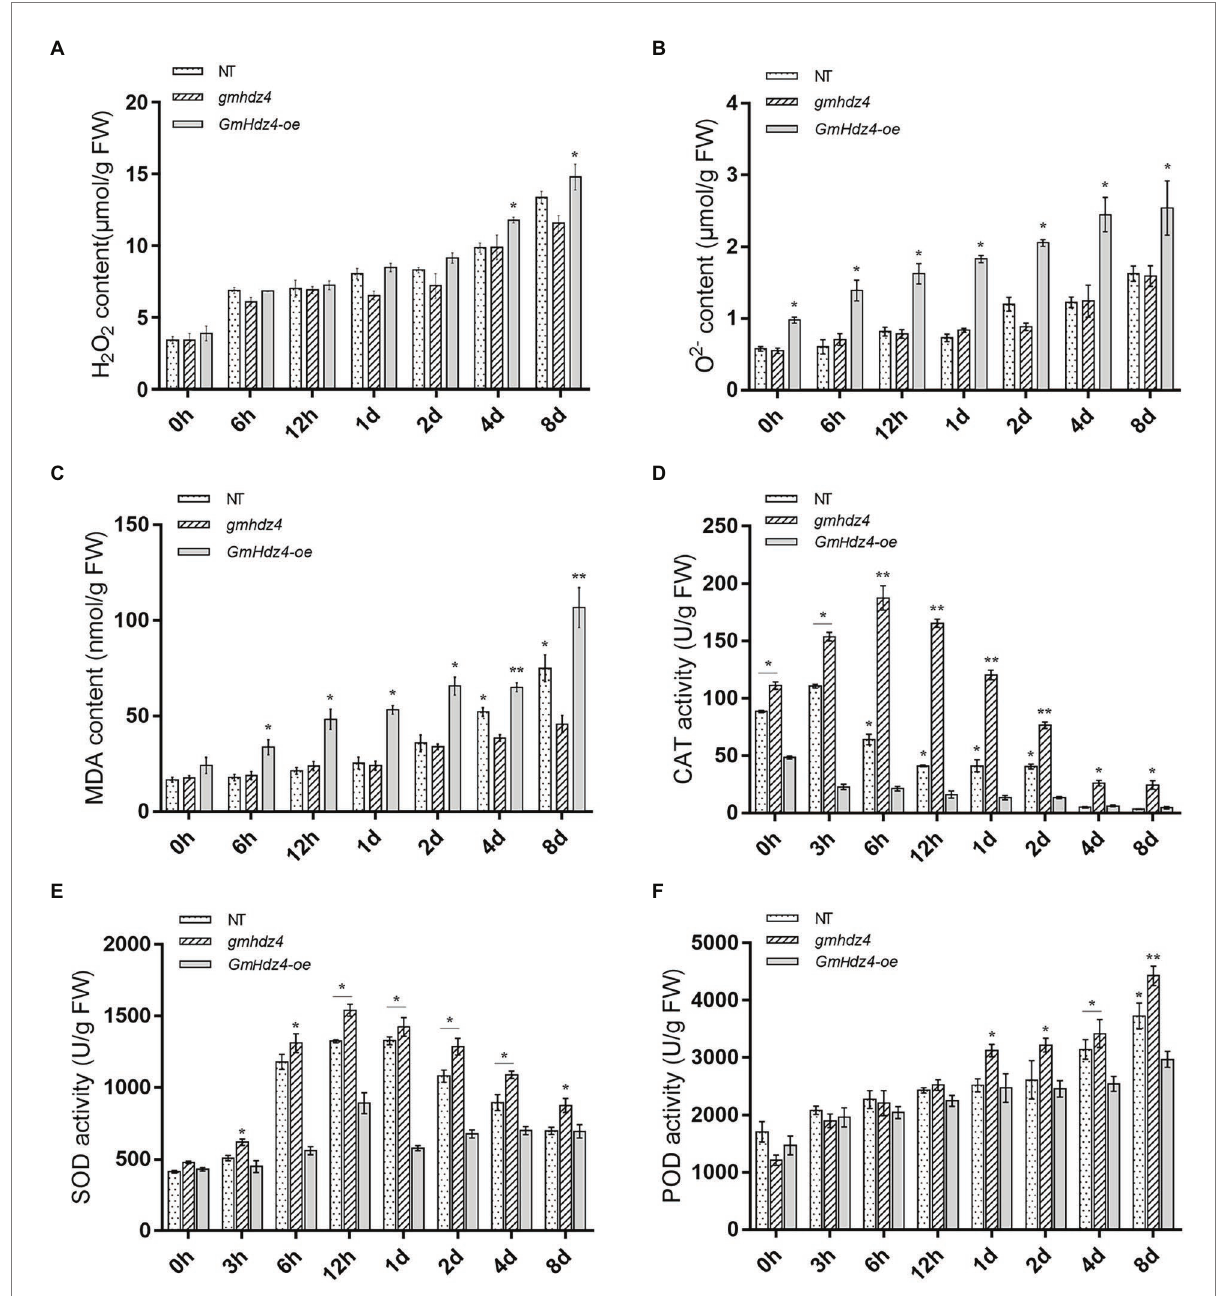
FIGURE 8 Knockout of GmHdz4 promotes ROS scavenging in response to drought stress. Contents of H 2 O 2 (A) , O 2 − (B) , and malondialdehyde (MDA) (C) , and activities of catalase (CAT) (D) , superoxide dismutase (SOD) (E) , and peroxidase (POD) (F) were tested to assess the antioxidation systems under drought stress. Significant differences are indicated by * and ** for p < 0.05 and p < 0.01, respectively, according to Duncan’s